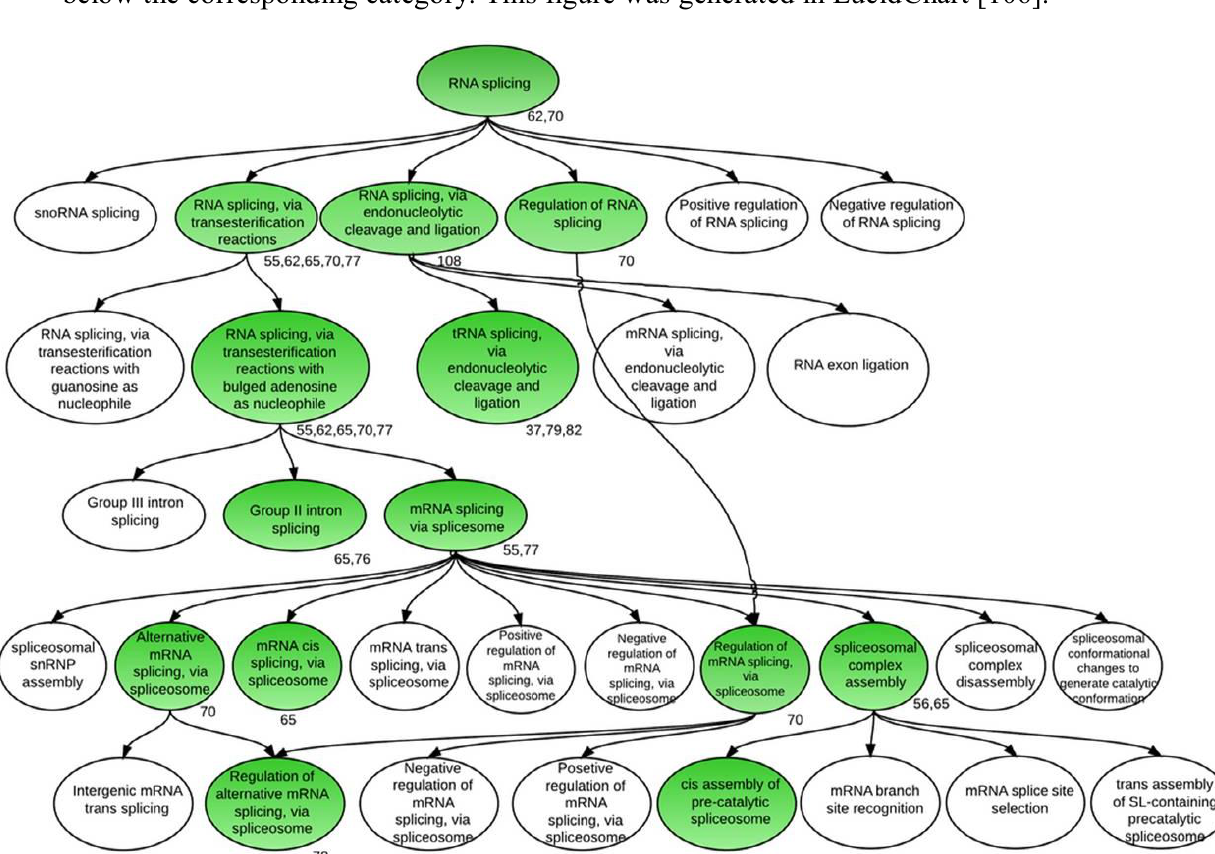
Figure 7. Tree displaying GO-enriched processes regulated by AS and associated with RNA splicing. Filtered enriched GO categories were searched for three keywords ( (cid:179)(cid:53)(cid:49)(cid:36)(cid:3) (cid:86)(cid:83)(cid:79)(cid:76)(cid:70)(cid:76)(cid:81)(cid:74)(cid:180)(cid:15)(cid:3)(cid:179)(cid:71)(cid:82)(cid:85)(cid:80)(cid:68)(cid:81)(cid:70)(cid:92)(cid:180)(cid:15)(cid:3)(cid:68)(cid:81)(cid:71)(cid:3)(cid:179) response to hormone stimulus (cid:180)(cid:12) in all 114 clusters and the GO database [66] was used to identify the parents and children for each GO term. These were then combined to obtain a single tree representing all enriched GO terms corresponding to each keyword. This large tree was then separated into three sub-trees corresponding to these three processes and the tree corresponding to the (cid:179)(cid:53)(cid:49)(cid:36)(cid:3)(cid:86)(cid:83)(cid:79)(cid:76)(cid:70)(cid:76)(cid:81)(cid:74)(cid:180)(cid:3)(cid:70)(cid:68)(cid:87)(cid:72)(cid:74)(cid:82)(cid:85)(cid:92)(cid:3)(cid:76)(cid:86)(cid:3)(cid:86)(cid:75)(cid:82)(cid:90)(cid:81) . GO terms that were enriched significantly ( p < 0.05) in genes involved in RNA splicing are shown in green. The clusters containing these RNA-splicing-related genes are shown below the corresponding category. This figure was generated in LucidChart